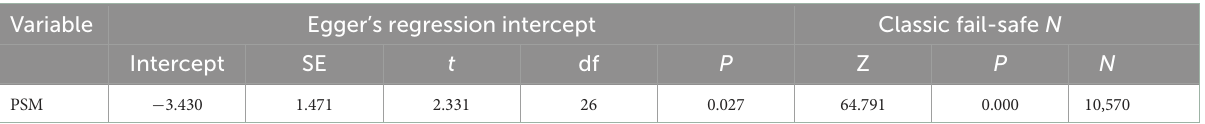
TABLE 2 Egger’s regression coefficient test and classic fail-safe N test results (these tests, along with the funnel pot are to determine if there is publication bias). Variable Egger’s regression intercept Classic fail-safe N